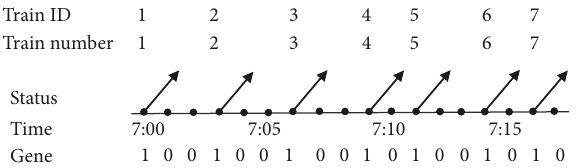
Figure 1: A coding example of the departure time at the starting station for an up